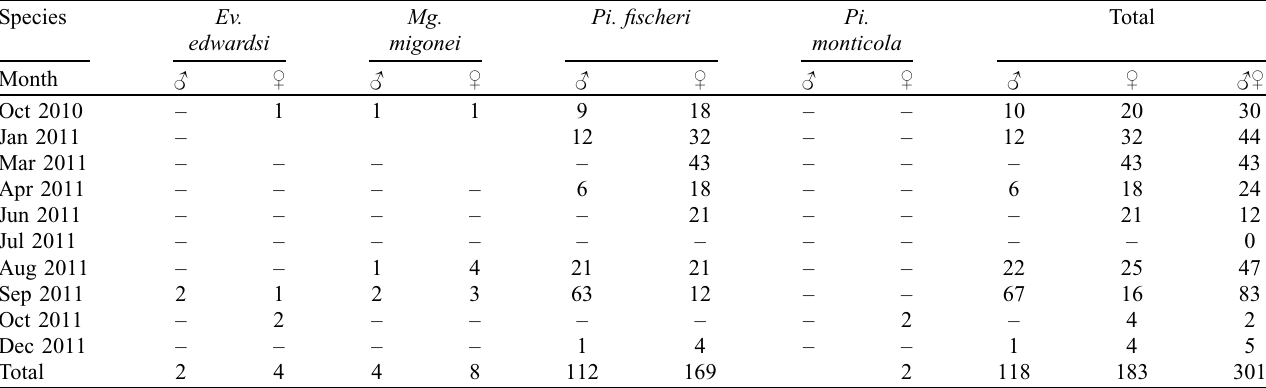
Table 1. Sandflies captured in kennel by month, sex, and species in Embu das Artes, São Paulo state, Brazil. Species